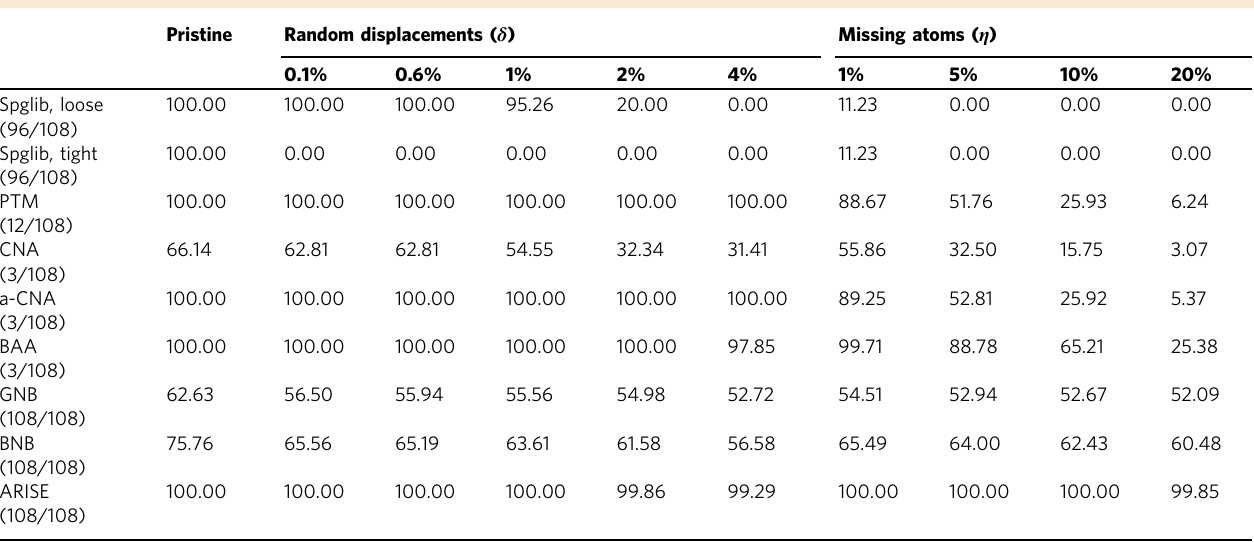
Table 2 Accuracy in identifying the parent class of defective crystal